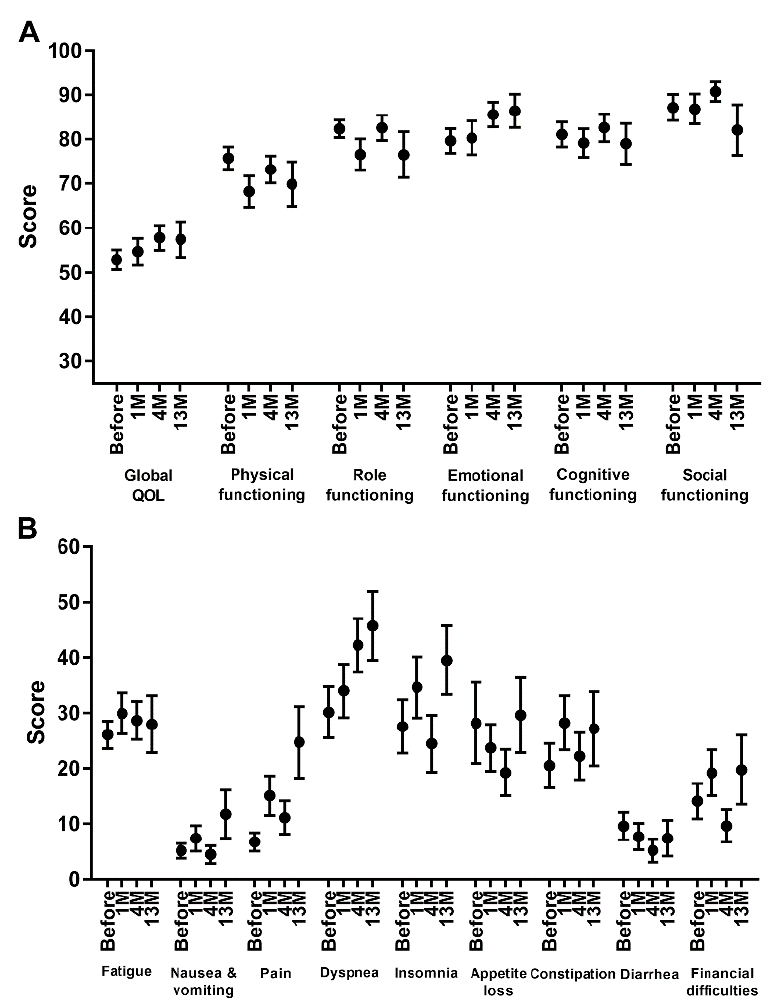
Figure 2. Changes in the mean scores for ( A ) global health status and functioning scales and ( B ) symptom scales before and after proton beat therapy. The bars represent mean scores with standard errors of the mean before proton beam therapy, followed by 1, 4, and 13 months after completion of proton beam therapy, respectively.